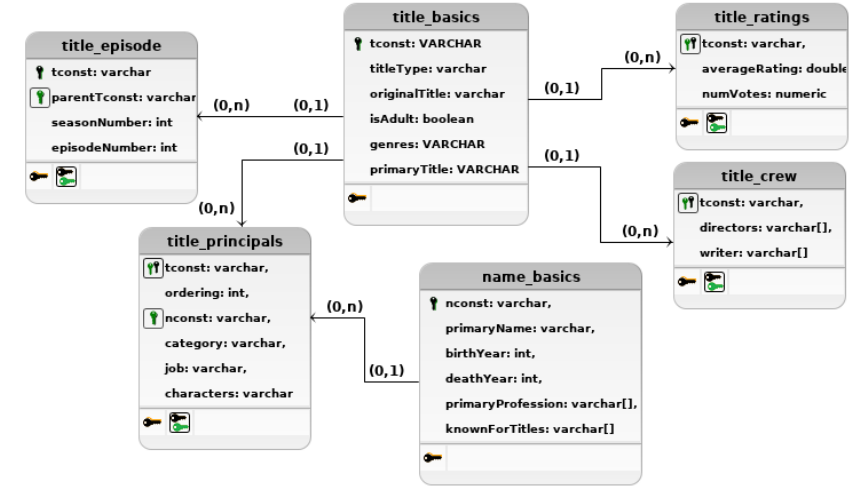
Figure 2. IMDb logic data